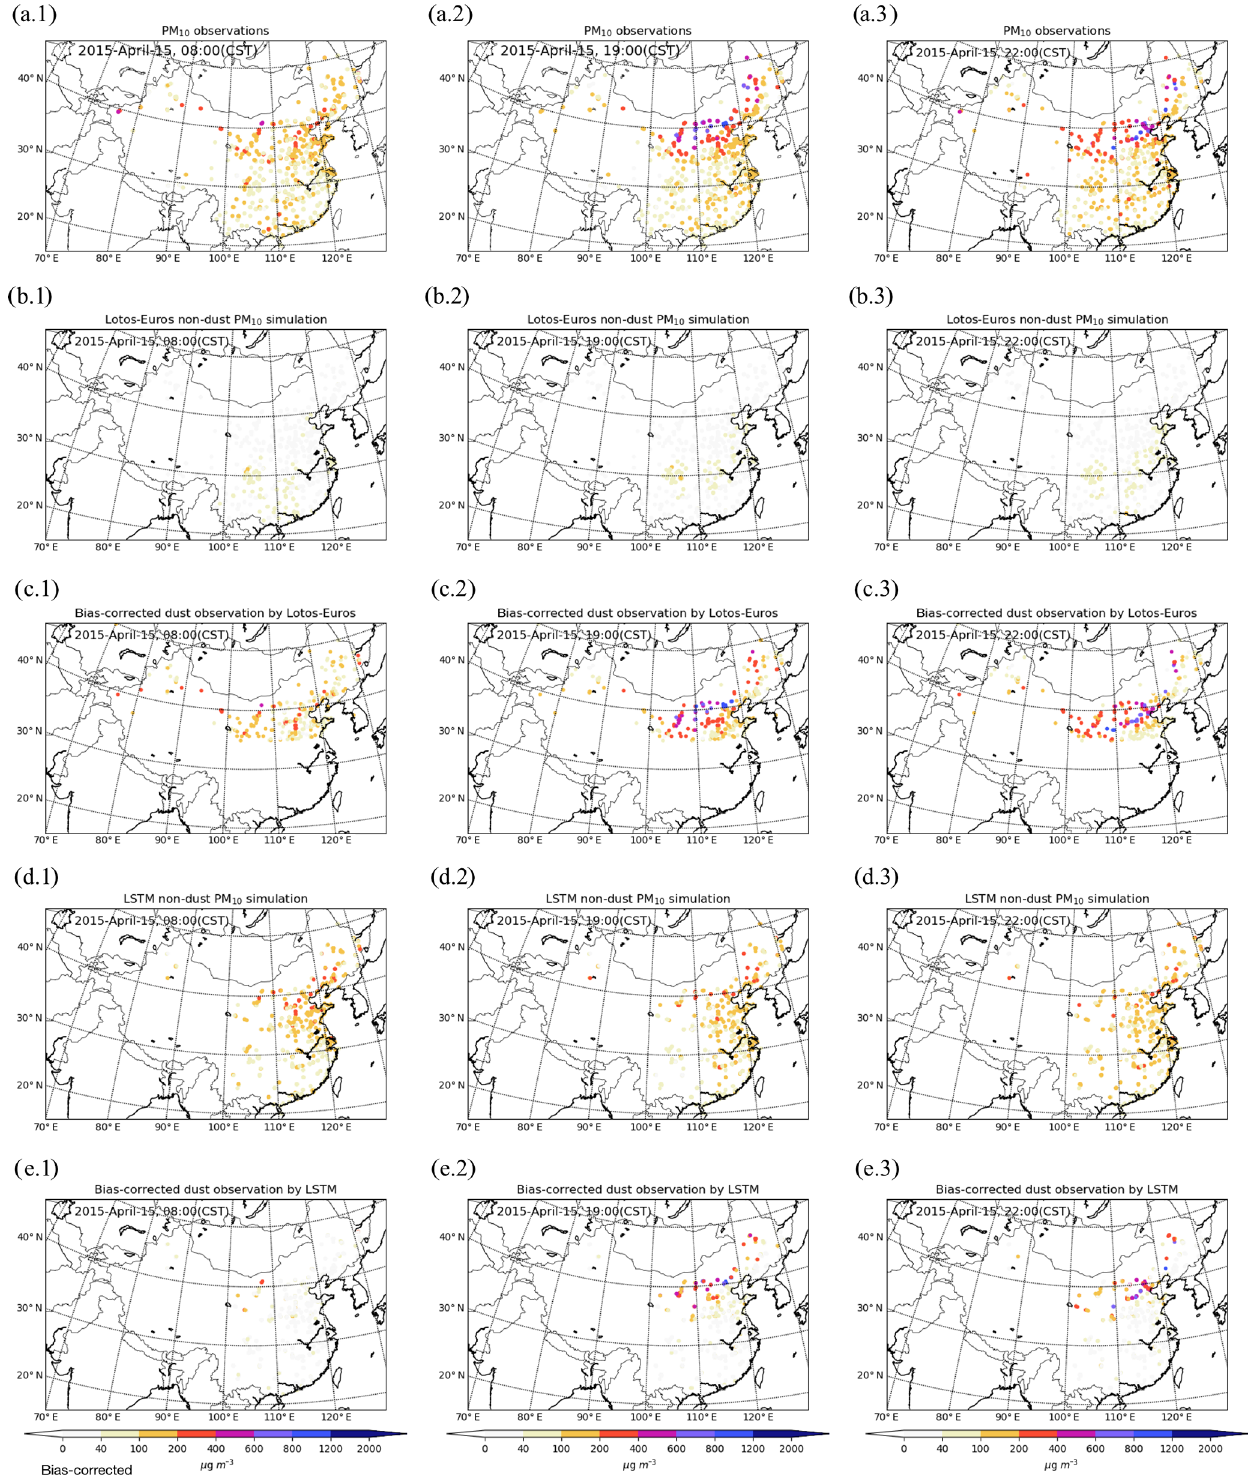
Figure 4. Original PM 10 measurements (a.1–a.3) , LOTOS-EUROS/non-dust simulated PM 10 (b.1–b.3) , the corresponding bias-corrected dust observations (c.1–c.3) , LSTM-predicted non-dust PM 10 (d.1–d.3) , and the derived dust observations (e.1–e.3) at three time